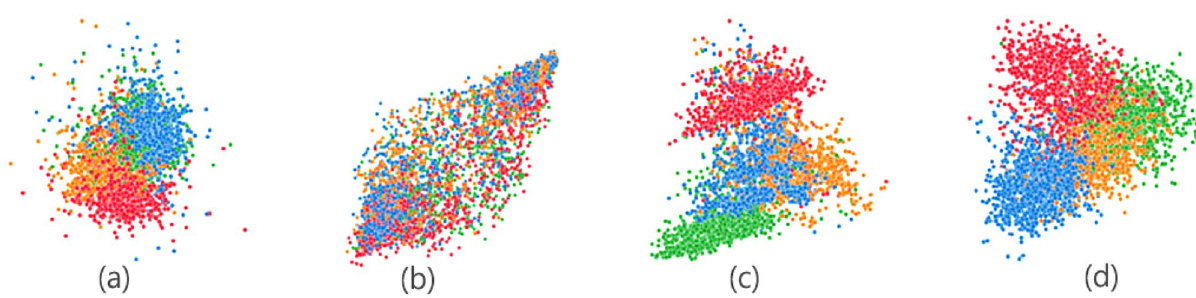
Figure 8. Visualization of node representations on DBLP ( a ) Metapath2vec ( b ) DMGI ( c ) HeCo ( d )